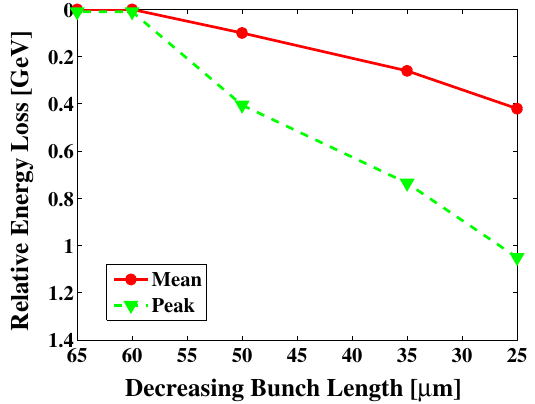
FIG. 13. (Color) Changing bunch length (Li)—The average and peak energy loss results from OOPIC